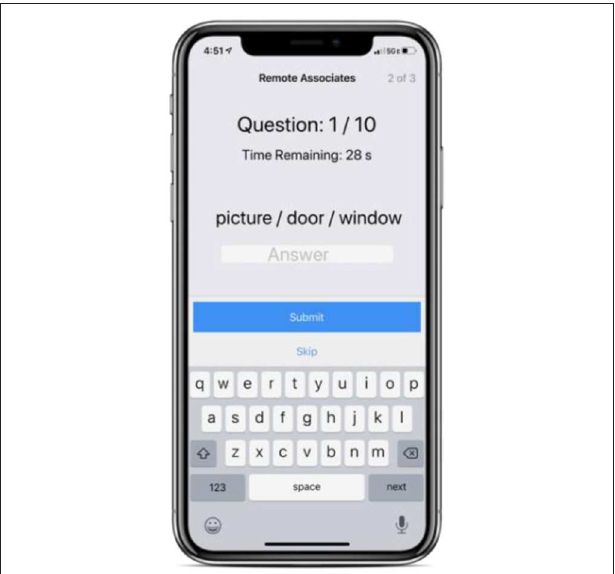
FIGURE 1 | Sample of Remote Associates Test.